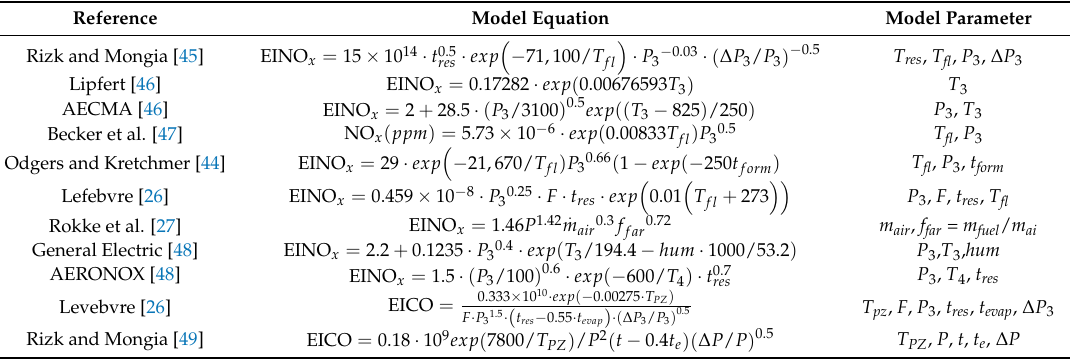
Table A1. The NO and CO correlations in the open literature. Scale